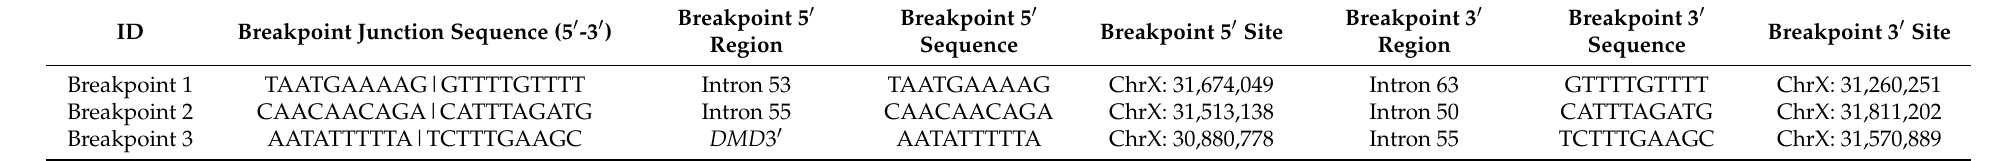
Table 1. Characteristics of DMD breakpoint junction